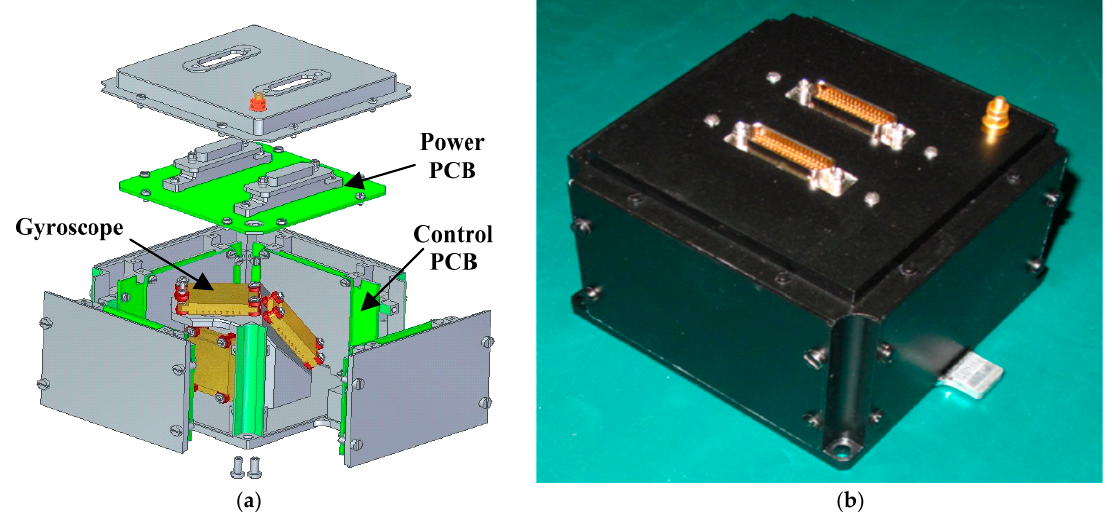
Figure 8. The MEMS rate sensor for space applications: ( a ) Mechanical architecture; ( b ) Photo of the MEMS